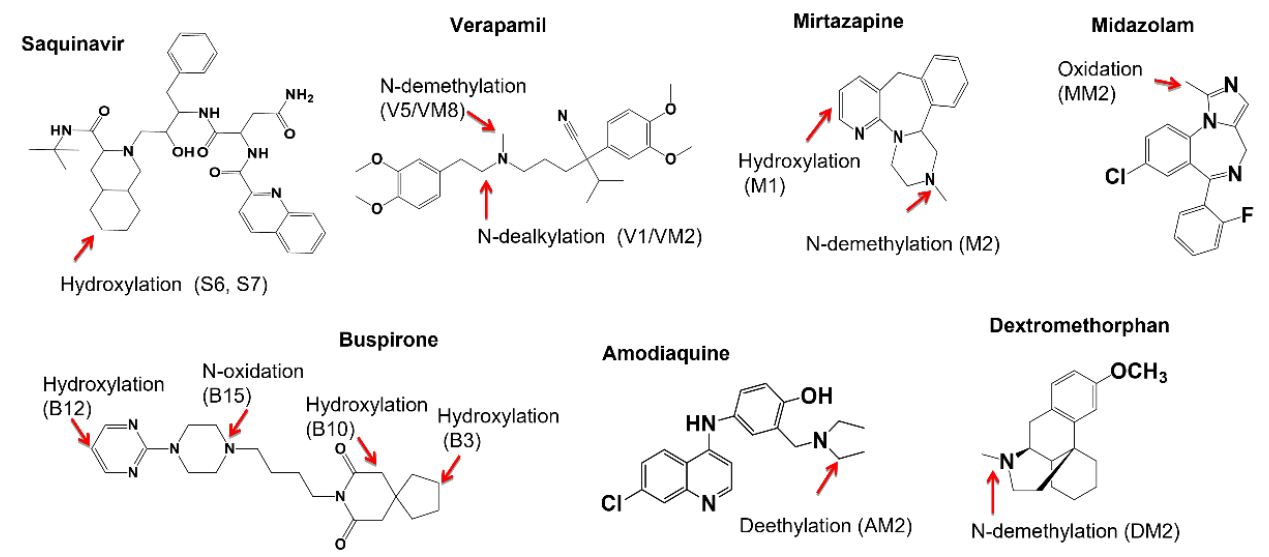
Figure 1. Metabolic soft-spots of seven model compounds, which were determined via HLM incubations (3 or 5 µM) for a compound-specific time followed by analysis using LC/UV/Q-TOF and/or LC/UV/Qtrap.